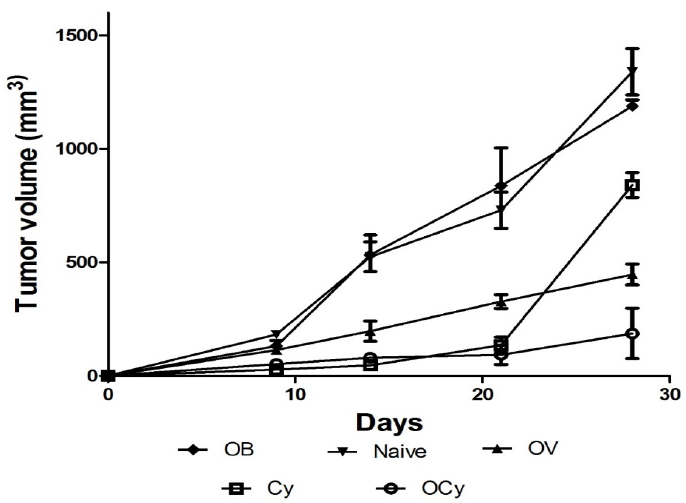
Figure 6. Tumor volumes in animals receiving the following treatments: naïve, blank microparticles (OB), cyclophosphamide (i.p., 50 mg/kg) (Cy), orally administered vaccine microparticles (OV), and